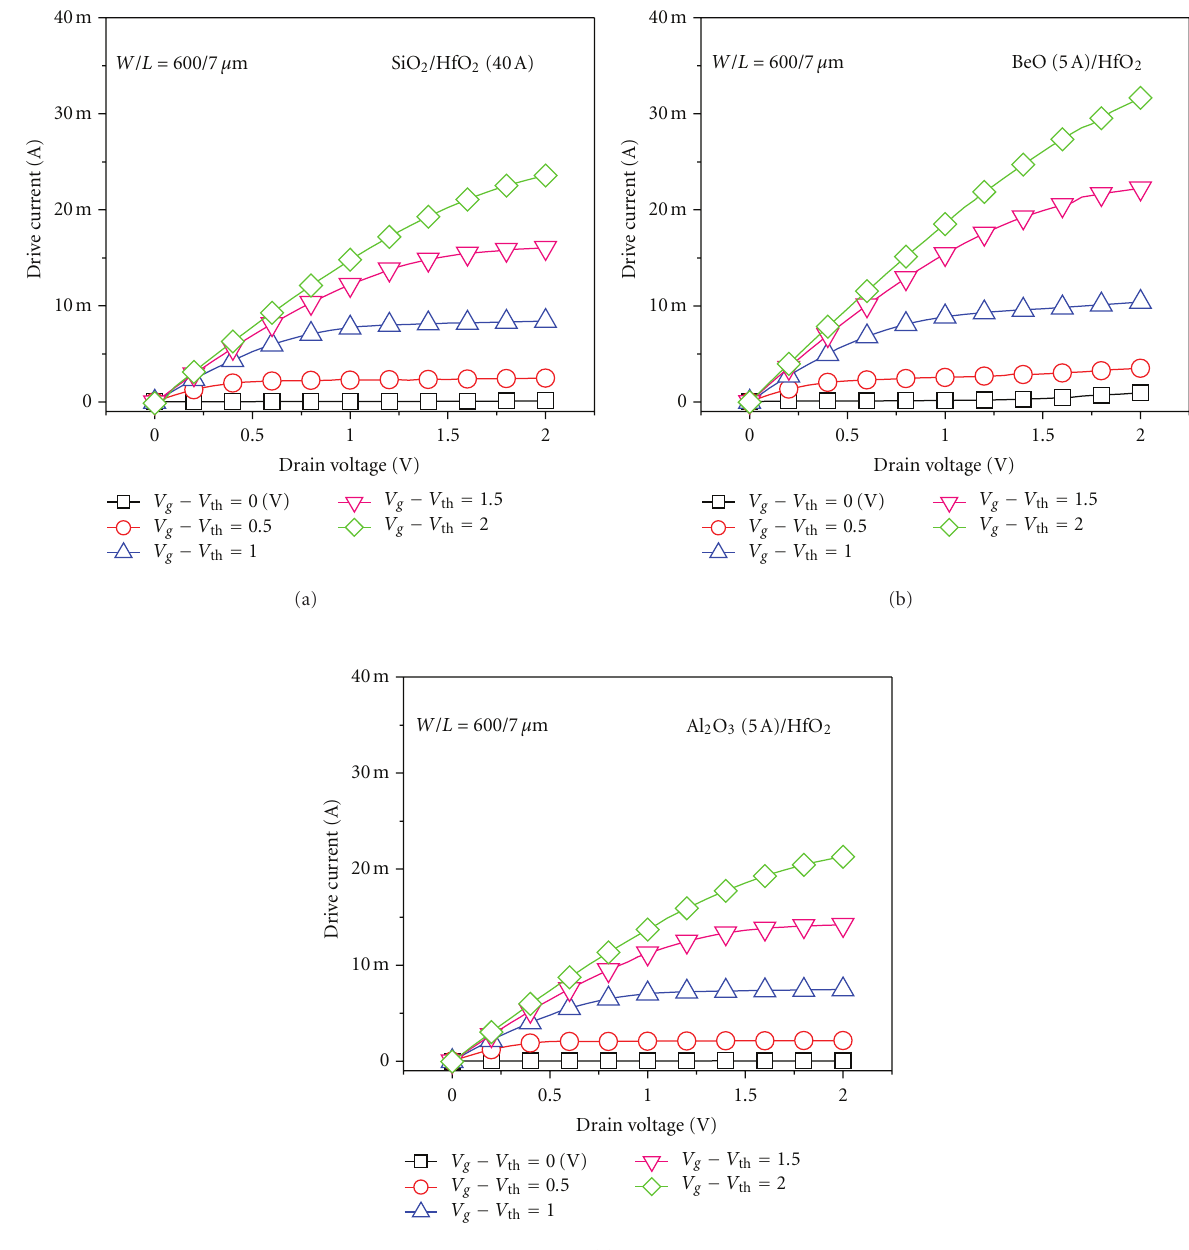
Figure 9: I d − V d characteristics of three gate stacks. BeO IL shows significant increased drive current compared to SiO 2 and Al 2 O 3 IL gate